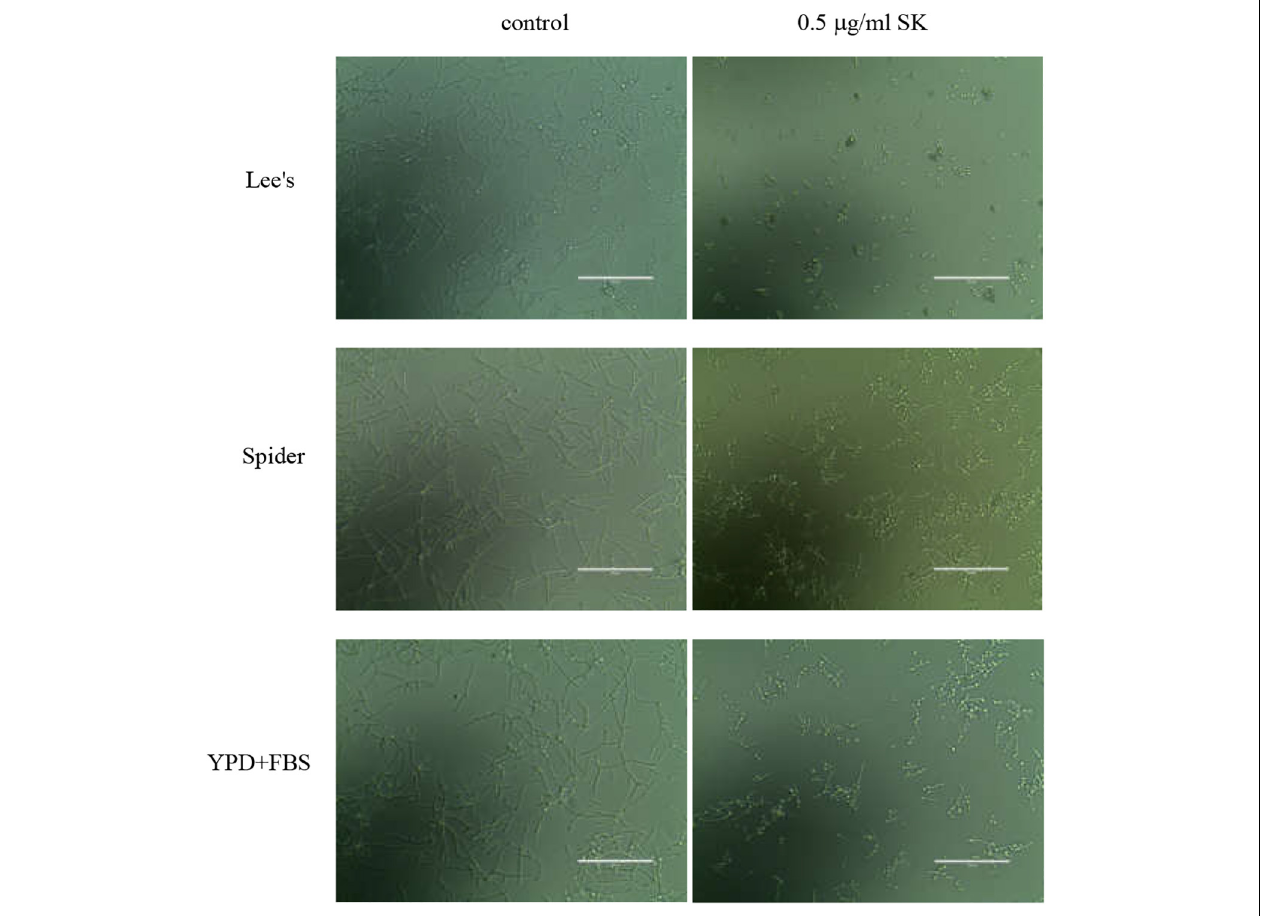
FIGURE 2 | Effects of SK on hyphae formation. C. albicans SC5314 cells were incubated in Lee’s, Spider or YPD liquid media supplemented by 10% fetal bovine serum (YPD + FBS). The cellular morphology was photographed after incubation at 37 ◦ C for 3 h.